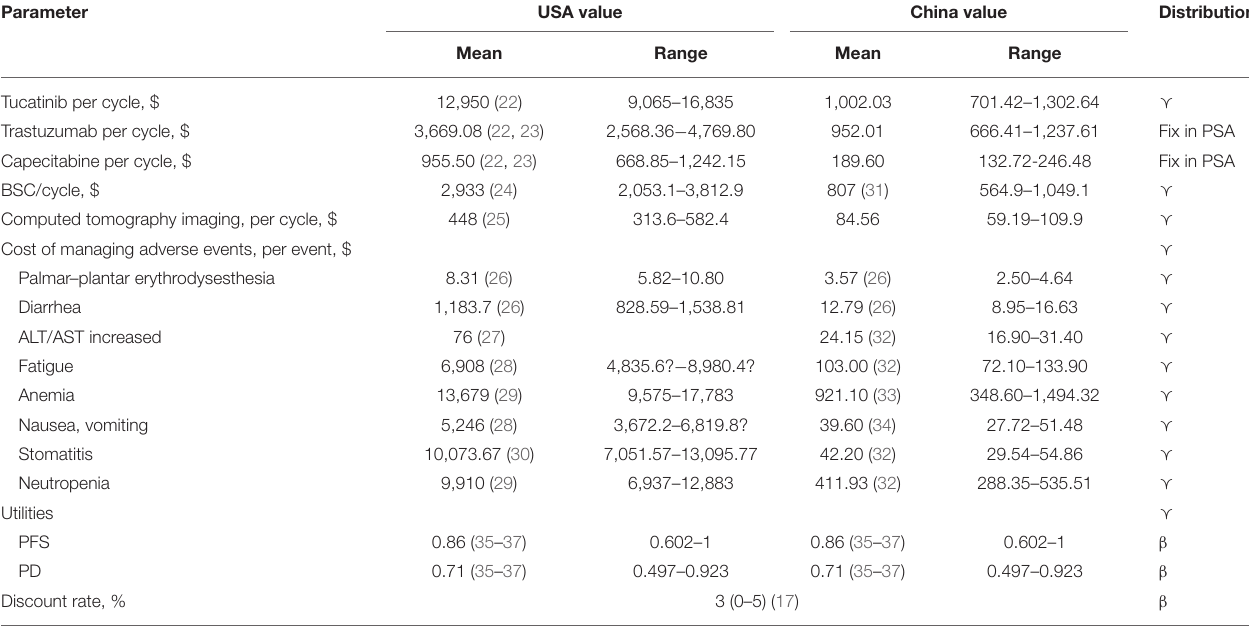
TABLE 1 | Model parameters and